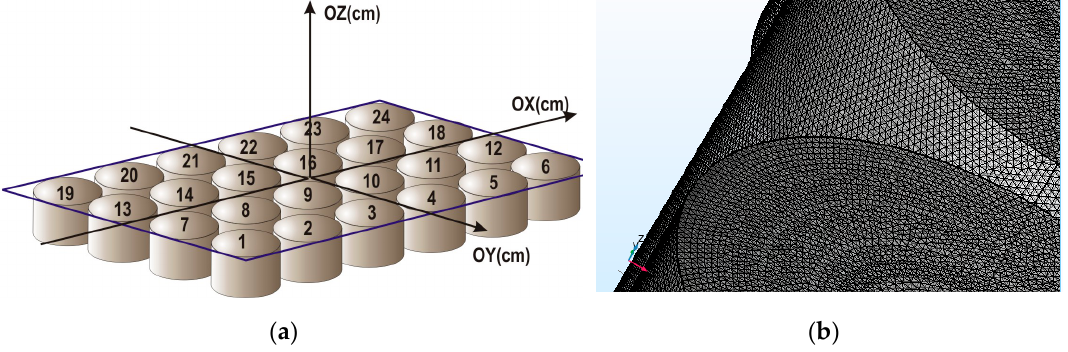
Figure 1. The geometry of the experiment and the model of the magnetic matrix ( a ). Segmented view of the mesh in finite-element modeling ( b ).